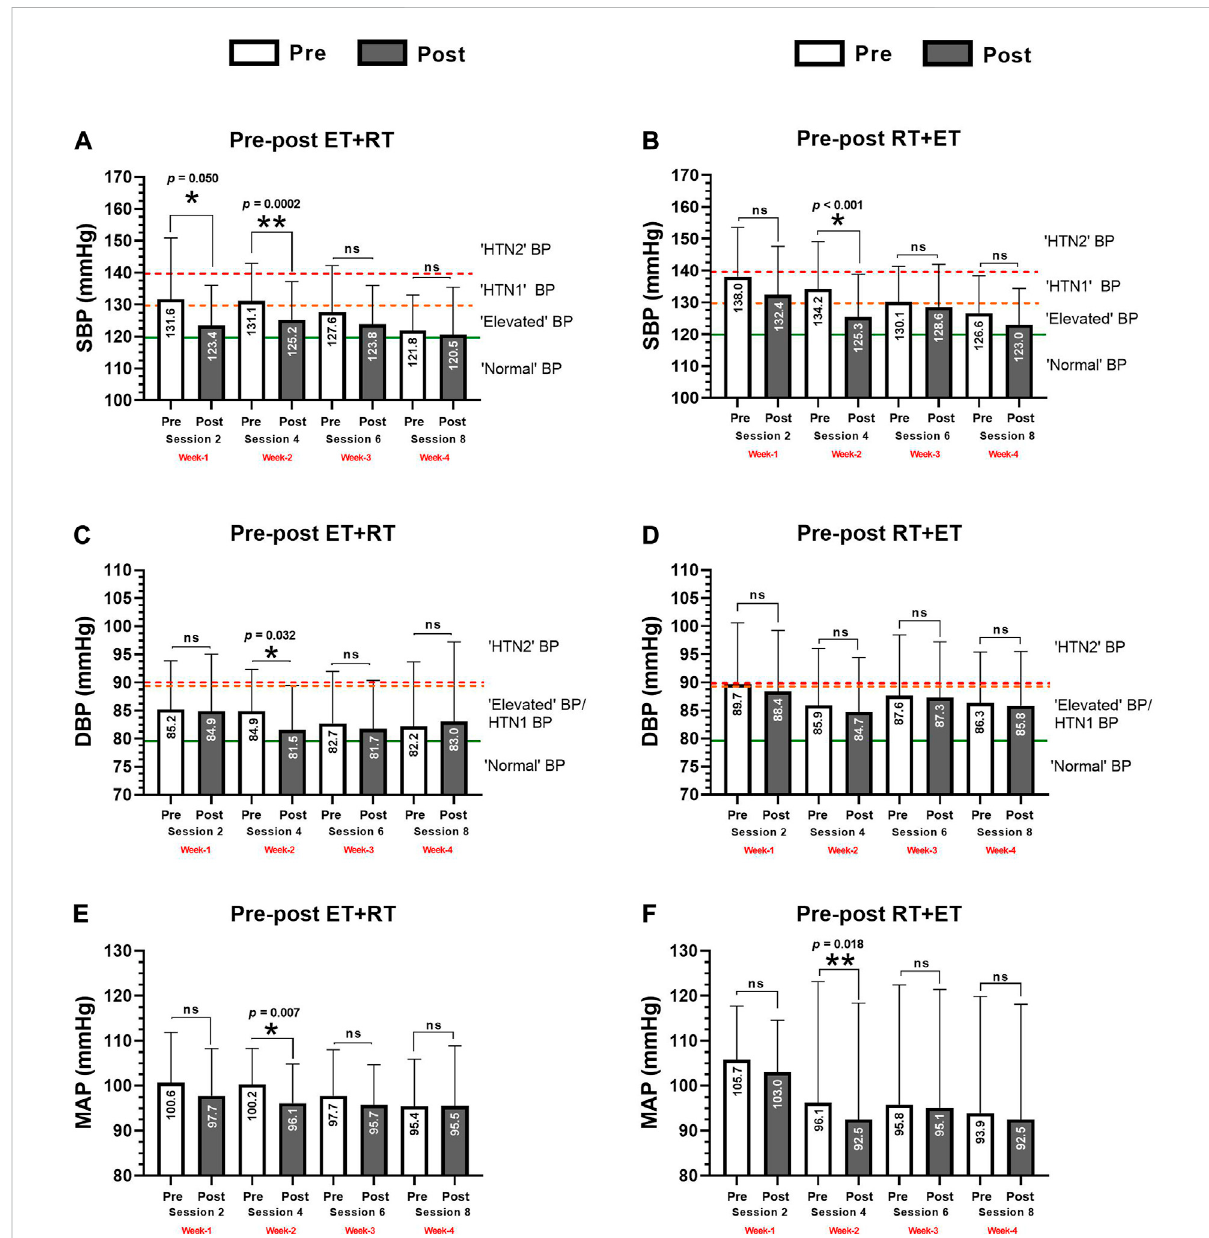
FIGURE 2 Acute absolute prepost changes in systolic (A, B) , diastolic (C, D) , and mean arterial blood pressure (E, F) after 4 weeks (eight exercise sessions) of twodifferentordersof concurrent training inmorbid obesity patients. Groupsare described as (ET + RT) endurancetraining plusresistance training group and (RT + ET) resistance training plus endurance training group. Outcomes are described as (SBP) systolic, (DBP) diastolic, and (MAP) mean arterial pressure. Cut-off points of blood pressure are described as; “ normal ” BP, “ elevated ” BP, “ HTN1 ” BP, and “ HTN2 ” BP following standard classi fi cation criteria. The green continuous line denotes the limit for normal “ normal ” BP. The orange intermittent line denotes limit for “ elevated ” BP. The red intermittent line denotes the limit for “ HTN2 ” BP. (*) denotes signi fi cant time prepost differences in each week at p < 0.05. (**) denotes signi fi cant time prepost differences in each week at p < 0.001. (ns) denotes no signi fi cant differences p >